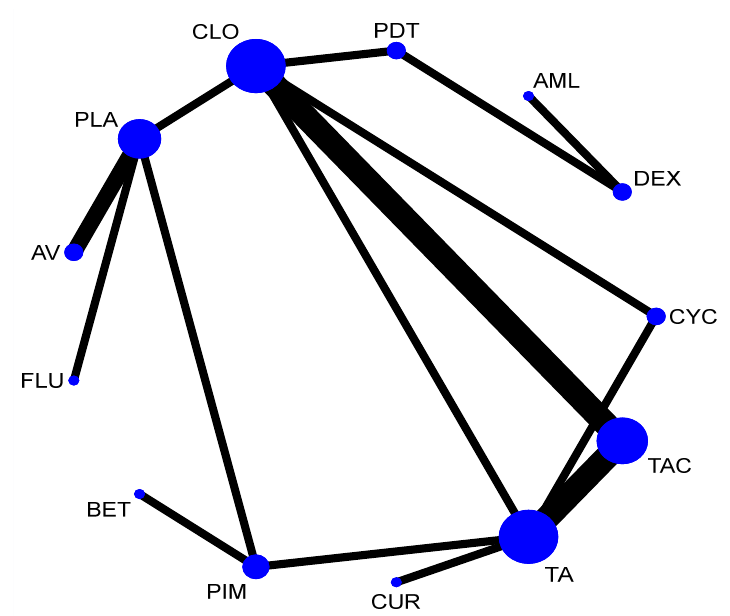
Figure 18. Network plot: Clinical Resolution (subgroup analysis). Abbreviations: AML, amlexanox paste; AV, aloe vera; CUR, curcumin gel; PDT, photodynamic therapy; PLA, placebo; PUR, purslane; TAC, tacrolimus; FLU, flucinonide acetonide; CLO, clobetasol propionate; PIM, pimecrolimus; BET, betamethasone; TA, triamcinolone acetonide; DEX, dexamethasone; CYC, cyclosporine.